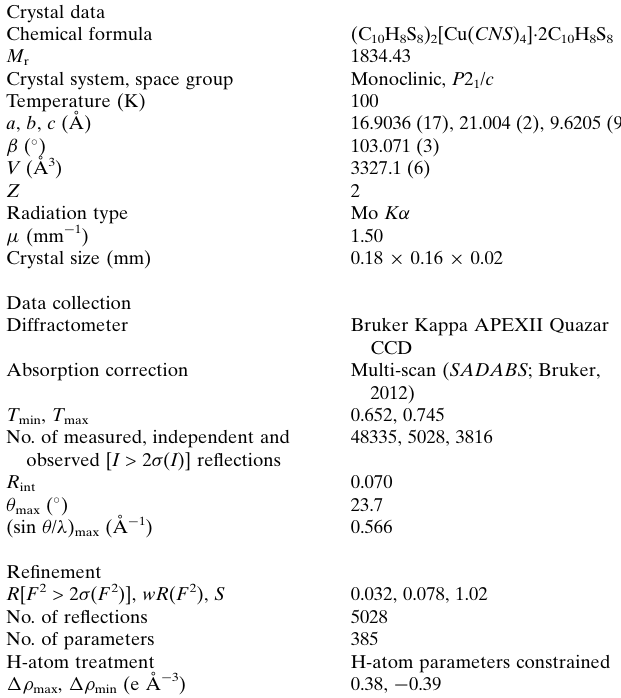
Table 2 Experimental